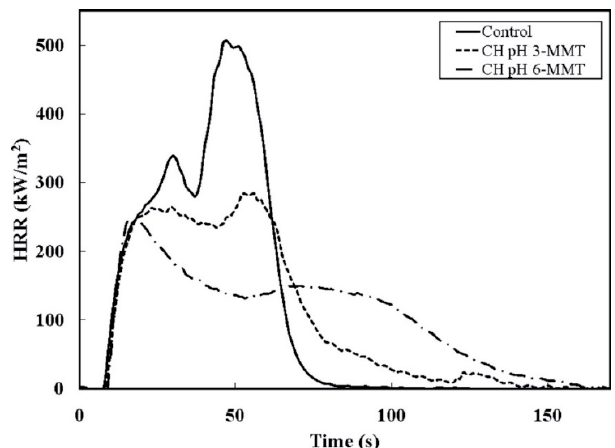
Figure 26. Heat-Release Rate (HRR) as a function of time during cone calorimeter testing for control (uncoated polyurethane foam) and for the foams coated with 10 bi-layers of chitosan/sodium montmorillonite at pH = 3 (CH pH 3-MMT) and at pH = 6 (CH pH 6-MMT). Reprinted with permission from [53]. Copyright 2012, American Chemical Society.